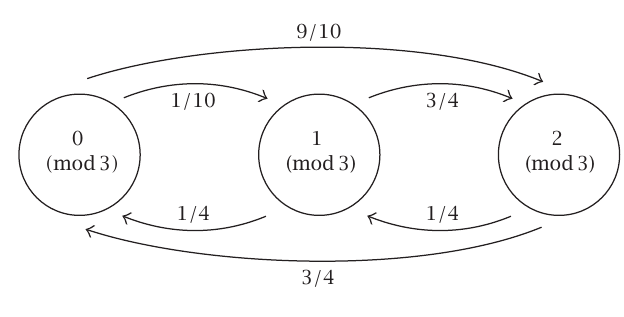
Figure 2.1 . Game B as a Markov